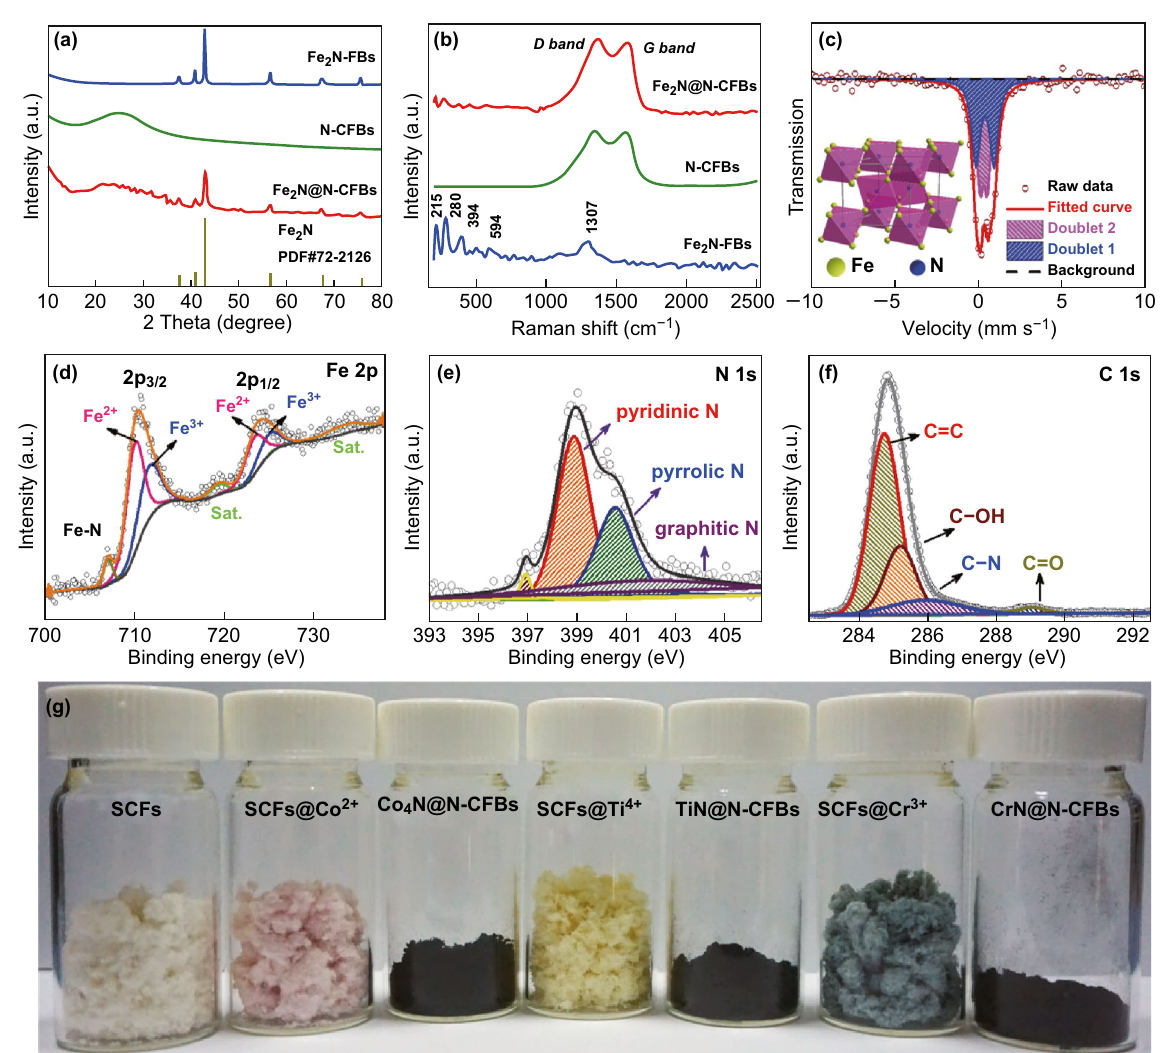
Fig. 2 a XRD patterns and b Raman spectra of Fe 2 N@N-CFBs, N-CFBs, and Fe 2 N-FBs. c Mössbauer spectrum of Fe 2 N@N-CFBs at room temperature. The inset shows the crystal structure of the orthorhombic Fe 2 N. d – f HR XP spectra of the Fe 2p, N 1s, and C 1s peaks of Fe 2 N@N-CFBs. g Photographs of SCFs, SCFs@M n + , and M x N y @N-CFBs (M = Co, Ti,